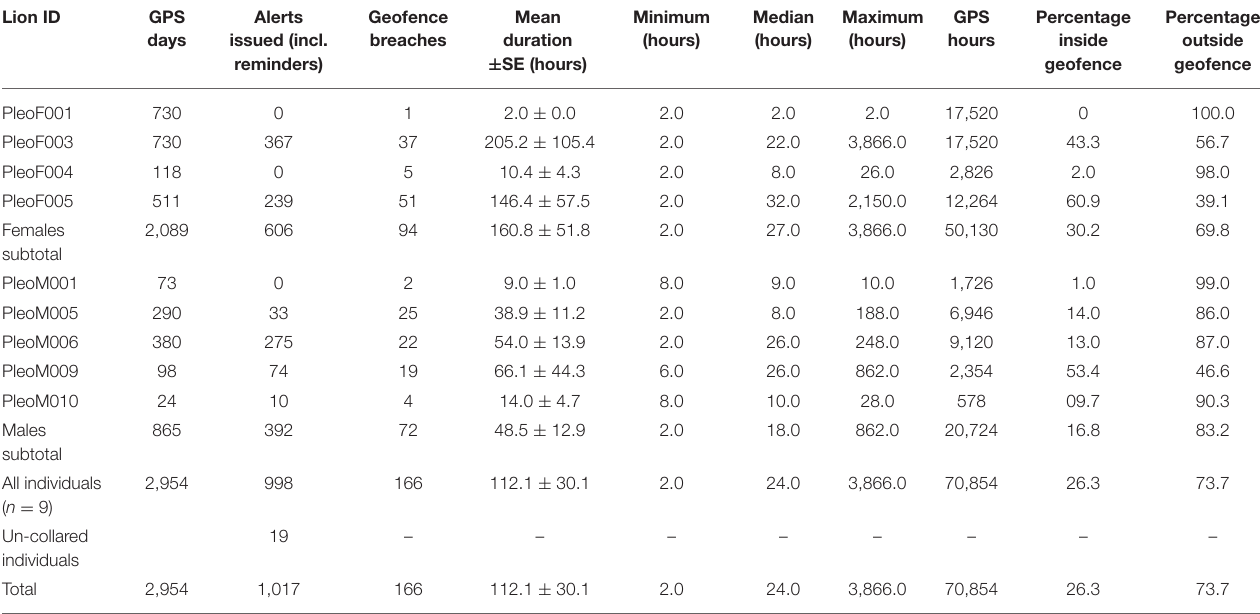
TABLE 2 | Summary of lion monitoring, geofence breaches, and alerts issued during the pilot study.